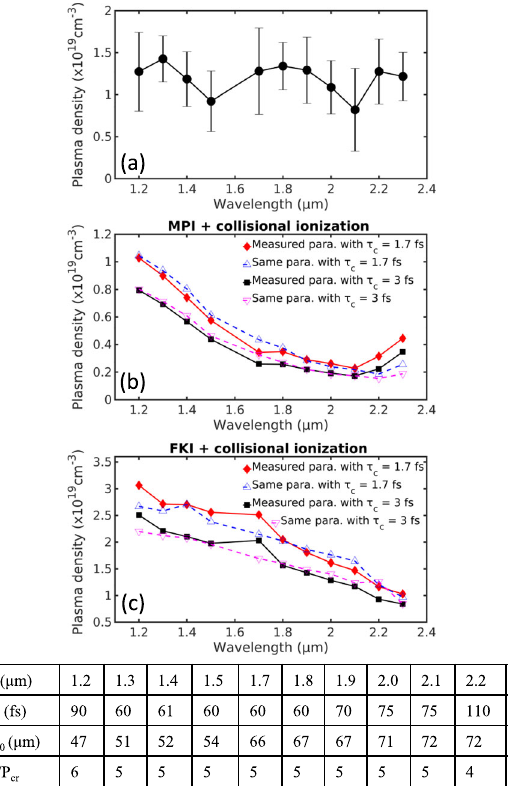
Fig. 1 Plasma density scaling with wavelength in fi lamentation. a Measured plasma density scaling with wavelength. Simulated plasma density scaling using b multiphoton ionization (MPI) and collisional ionization, and c full Keldysh ionization (FKI) and collisional ionization. Simulations are performed with the measured parameters (measured para.,) [red diamond and black square] and also with the same (input beam) parameters (same para.) ( P = 5 P cr , τ p = 70 fs, w 0 = 60 μ m and no chirp) [blue triangle and magenta downward triangle]. The full list of measured parameters is in the table displayed in d . In the simulations, constant electron collision times τ c = 1.7 and 3 fs are used for all the wavelengths. d Table of experimental parameters; λ : wavelength, τ p : FWHM pulse duration, w 0 : 1/ e 2 beam radius, and P/P cr : normalized input peak power with respect to critical power. The error bars in a correspond to the standard deviation of 35 laser shots.